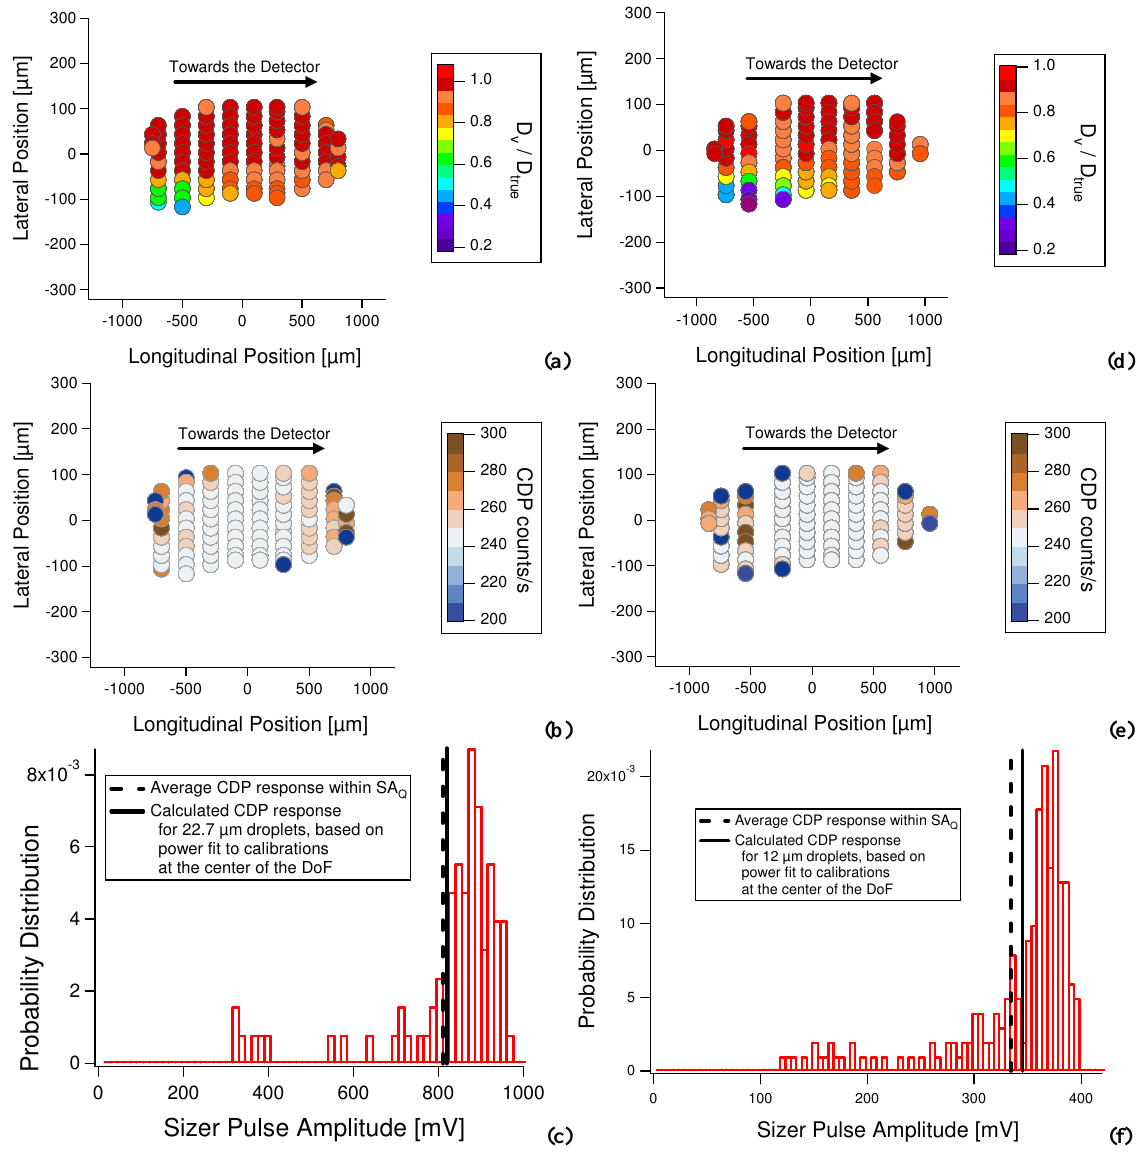
Fig. 6. Calibrated CDP sizing and counting response as a function of lateral and longitudinal position using 22µm ( a and b ) and 12µm ( d and e ) water drops, at 35–40ms − 1 velocity. (c) and (f) show histograms of the sizer pulse amplitude within SA Q .